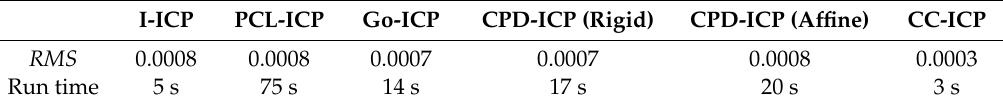
Table 2. Reference points errors.